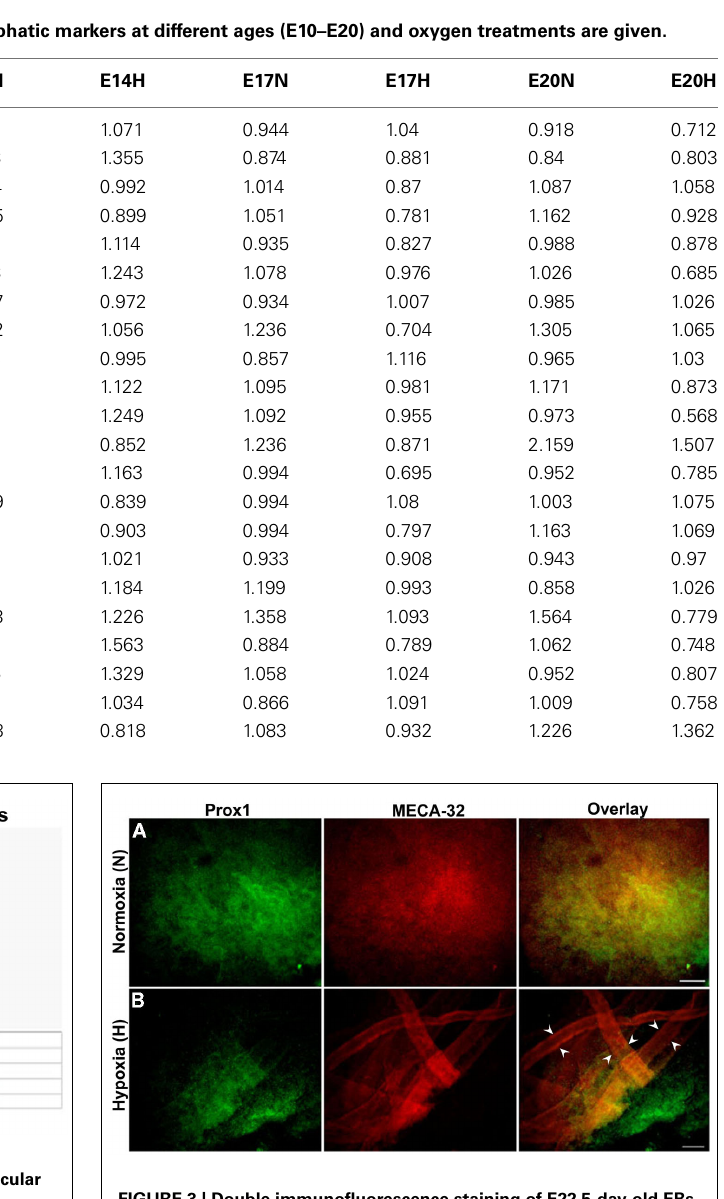
FIGURE 3 | Double immunofluorescence staining of E22.5-day-old EBs. Representative results from three different experiment sets for each marker genes are shown. Lymphatic ECs (LECs) and vascular ECs (BECs) are identified with Prox1 (green) and MECA-32 (red) markers respectively. EBs were grown under normoxic or hypoxic conditions as described in the Section “Materials and Methods.” (A) Normoxic EBs allowed differentiation of both BECs and LECs but failed to form vessel-like structures. (B) Hypoxia alone induces a network of blood vessel-like structures, indicated by arrowheads and early differentiation of LECs. Images were taken at 40 × magnification (scale bar 30 μ